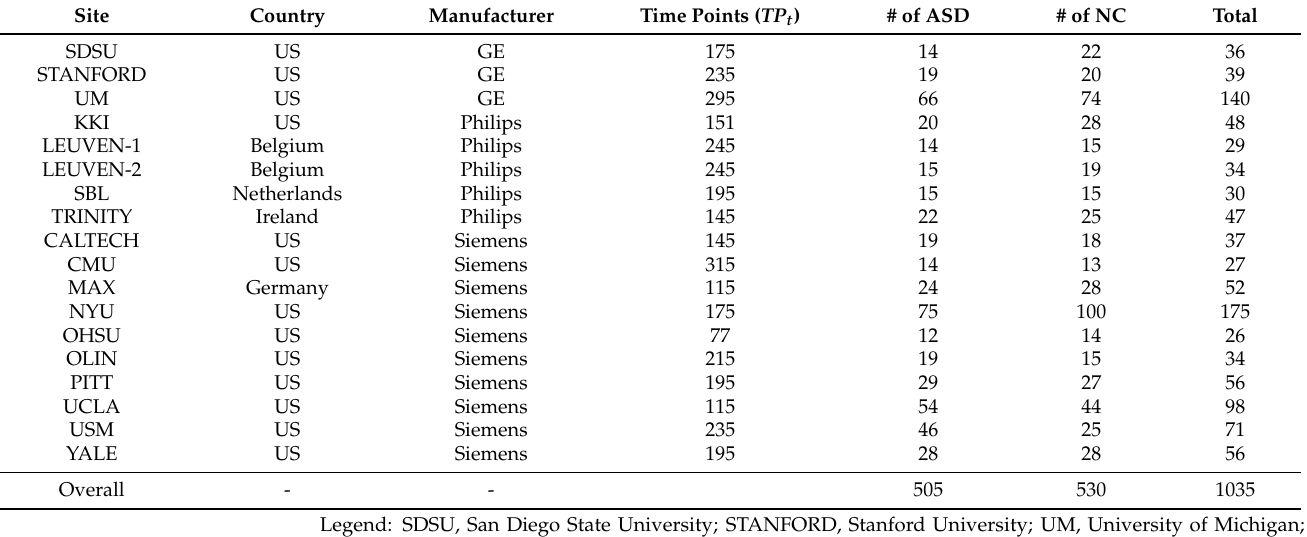
Table 1. Details of rs-fMRI ABIDE database for ASD and NC subjects acquired using 3T MRI